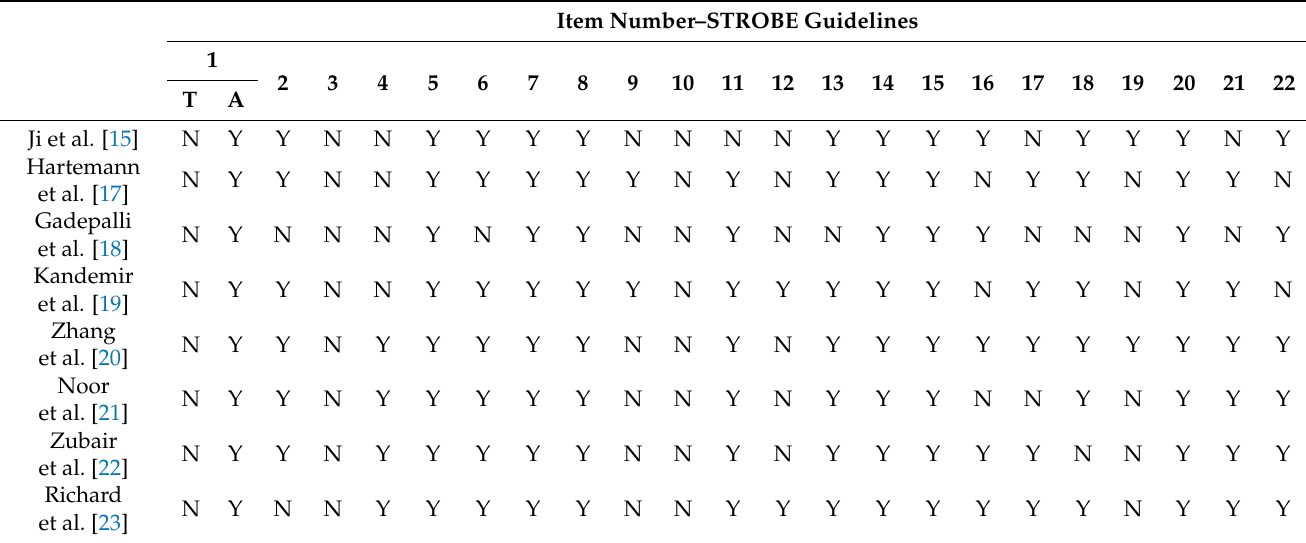
Table 2. Rating for the Strengthening the Reporting of Observational studies in Epidemiology (STROBE) checklist. Item Number–STROBE